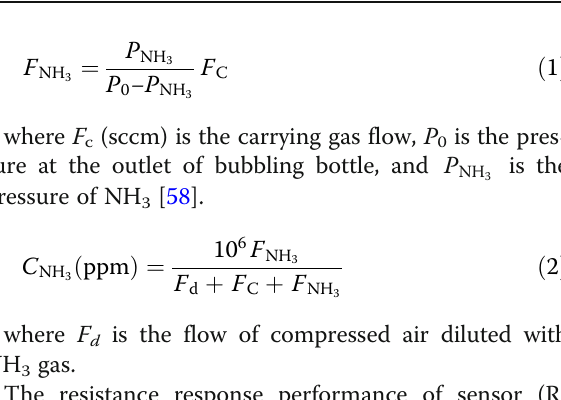
Fig. 5 SEM images of a rHGO bridged electrode arrays and b the enlarged image of selected area